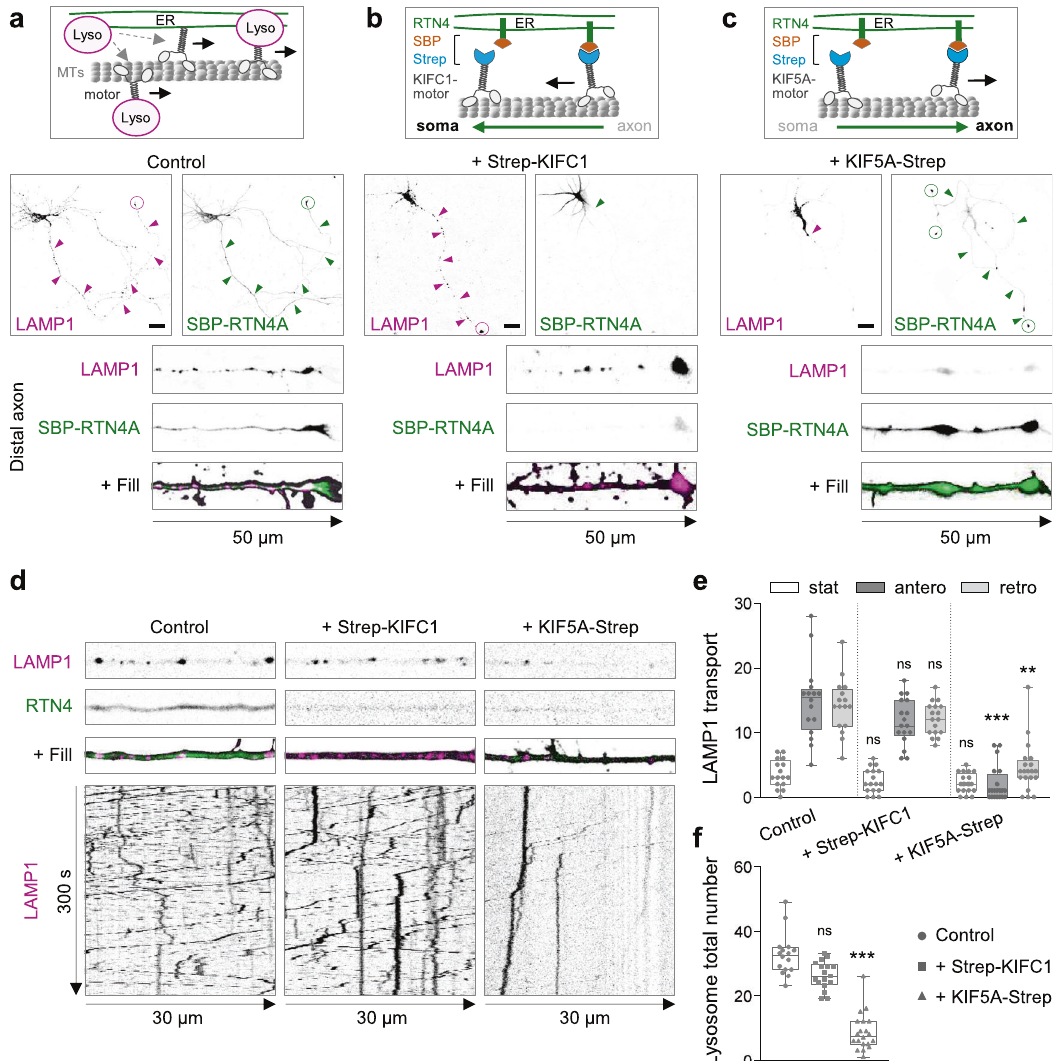
Fig. 2 Somatic ER tubules control lysosome translocation into the axon. a Schematic model for motor-driven lysosome transport regulated by ER tubules (top). Representative images of LAMP1-RFP (magenta) and GFP-SBP-RTN4 (green) distribution in a control DIV6 neuron co-transfected with fi ll (middle), and higher magni fi cation of distal axon (bottom). b Schematic representation of Streptavidin (Strep)-SBP heterodimerization system using SBP-RTN4 and Strep-KIFC1 for MT-dependent minus-end ER tubule transport and its persistent somatic retention (top). Representative images of LAMP1-RFP (magenta) and GFP-SBP-RTN4 (green) distribution in a neuron co-transfected with Strep-KIFC1 and fi ll (middle) and higher magni fi cation of distal axon (bottom). c Schematic representation of Strep-SBP system using SBP-RTN4 and KIF5A-Strep for MT-dependent anterograde transport of ER tubules and its persistent distribution in distal axons (top). Representative images of LAMP1-RFP (magenta) and GFP-SBP-RTN4 (green) distribution in a neuron co-transfected with KIF5A-Strep and fi ll (middle) and higher magni fi cation of distal axon (bottom). d , f Representative still images (top) and kymographs (bottom) from a proximal axon of live neurons co-transfected with LAMP1-RFP (magenta) and SBP-RTN4 (green), in absence of a motor protein (control; n = 16), or with Strep-KIFC1 ( n = 17) or KIF5A-Strep ( n = 20) (from left to right) in d . Quanti fi cation of stationary, anterograde and retrograde movement of lysosomes from conditions in ( d ), in ( e ). Quanti fi cation of average total number of lysosomes from conditions in ( d ), in ( f ). See also Supplementary Movie 4. Magenta and green arrows point to the abundance of LAMP1 and SBP-RTN4 along the axon and dashed circles point to their accumulation at axon tips. Scale bars represent 20 µ m in ( a – c ). Images are representative of three independent experiments in ( a – c ). Boxplot shows 25/75-percentiles, the median, and the individual datapoints each represent a neuron. Whiskers represent min to max values; ns — not signi fi cant, *** p < 0.001 and ** p < 0.01 comparing conditions to control (Kruskal – Wallis test followed by a Dunn ’ s multiple comparison test) in ( e ) and ( f ). Source data and exact p values are provided as a Source Data fi le. See also Supplementary Fig. 2b, d,